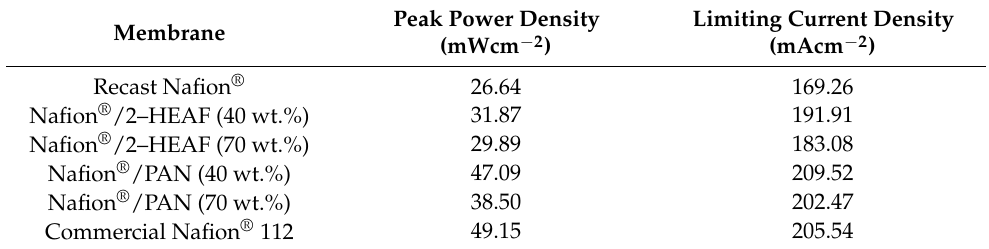
Table 4. Peak power density and limiting current density for all membrane